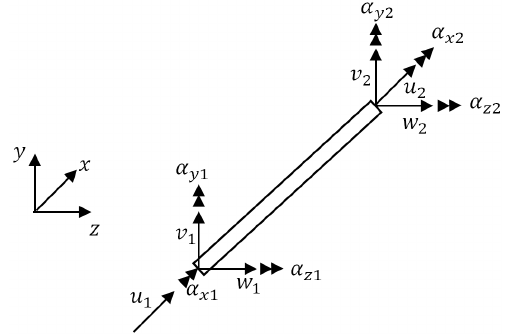
Figure 4. FEM 12-DOF beam